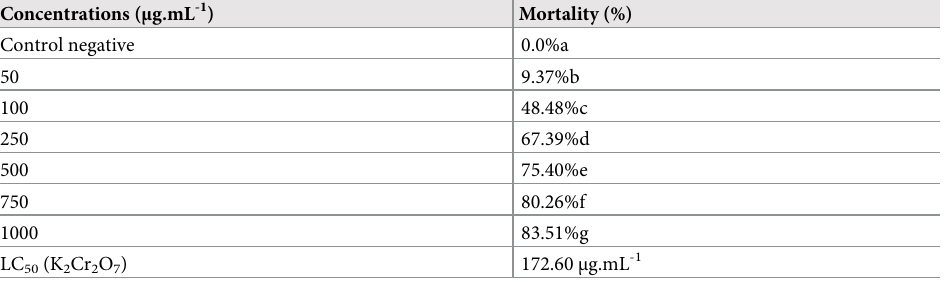
Table 6. Shows the percentage of cytotoxic activity of O . majorana L. essential oil at different concentrations. Concentrations ( μ g.mL -1 ) Mortality (%) Control negative